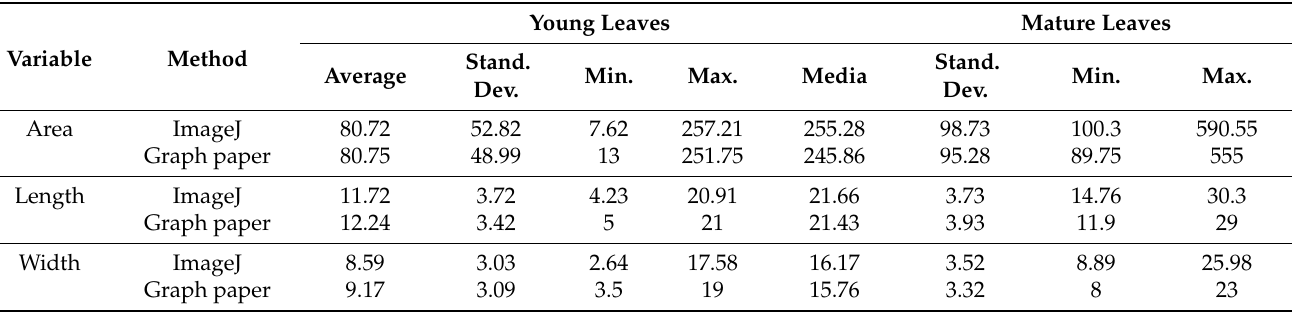
Table 1. Summary statistics of young and mature leaf dimensions measured by the ImageJ software and millimeter